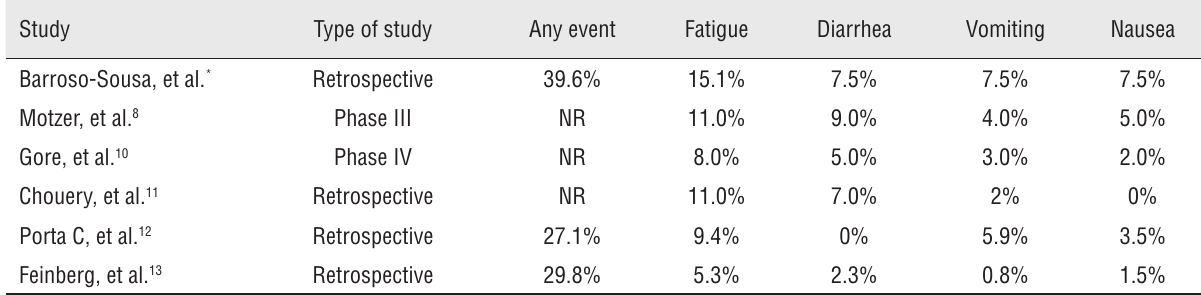
Table 4 - Reported grade 3 or higher adverse events in studies evaluating sunitinib in mRCC population.